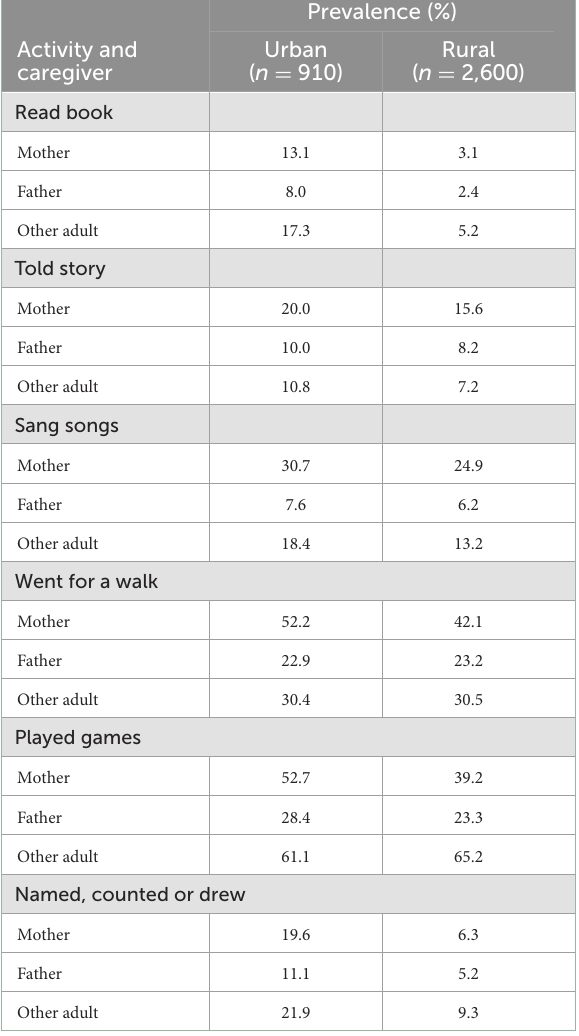
TABLE 7 Prevalence with which different caregivers engaged urban and rural 36- to 59-month-old children in Côte d’Ivoire in home-based activities that promote